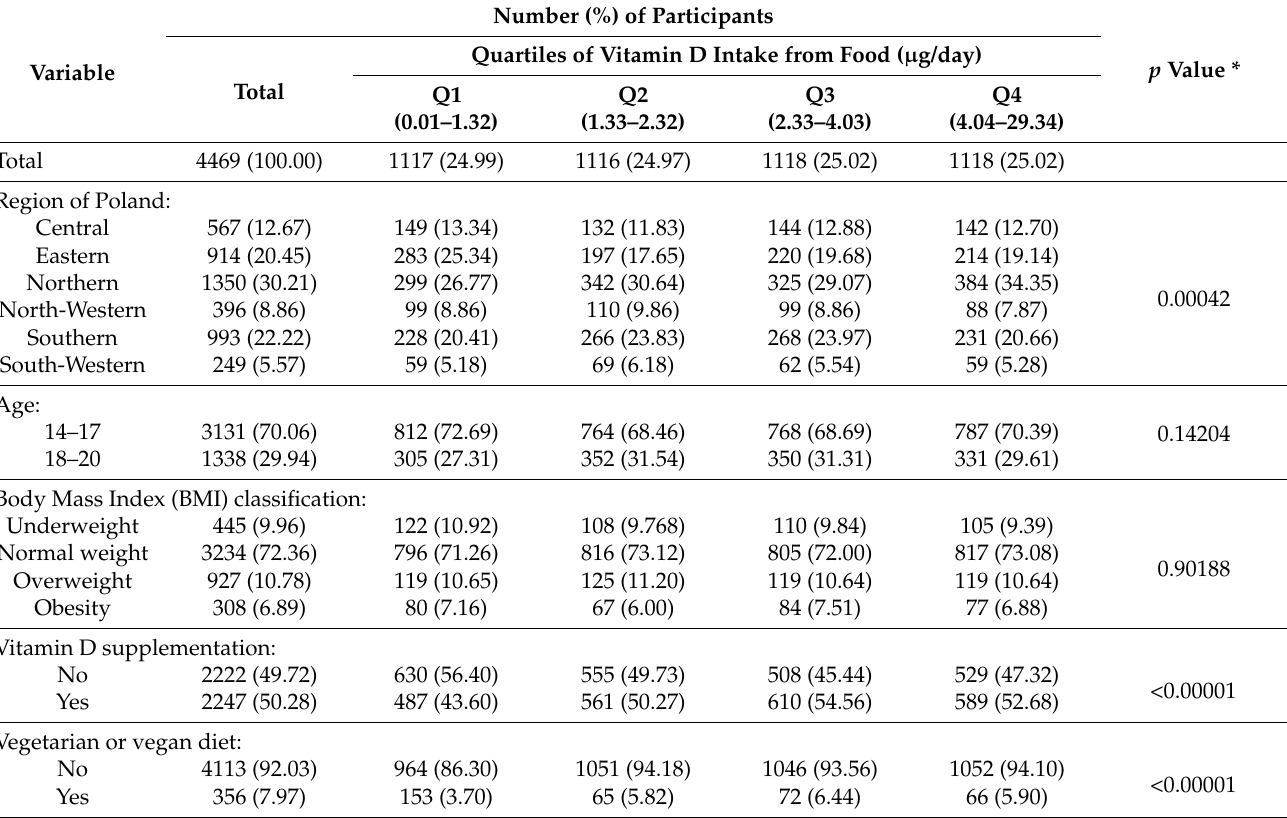
* Chi-squared test for comparisons of proportions, p ≤